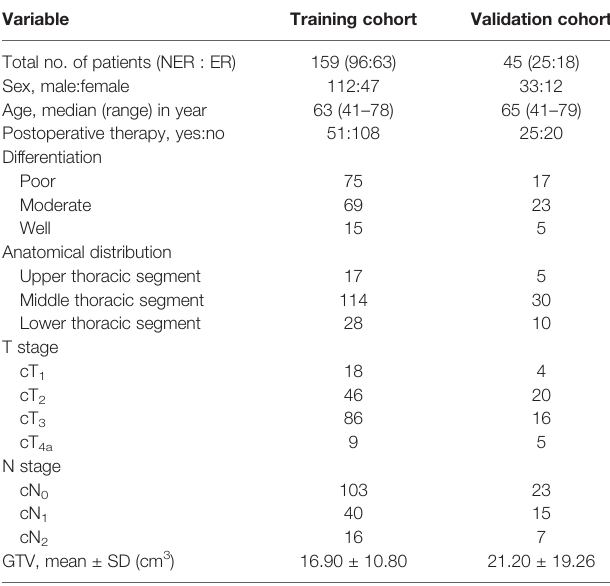
TABLE 1 | Demographic and clinical information of the enrolled patients. Variable Training cohort Validation